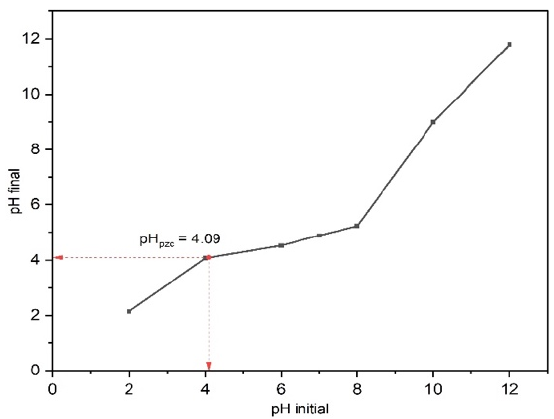
Figure 7. The pH pzc plot of 15BCPC using a 0.1 M NaCl solution.